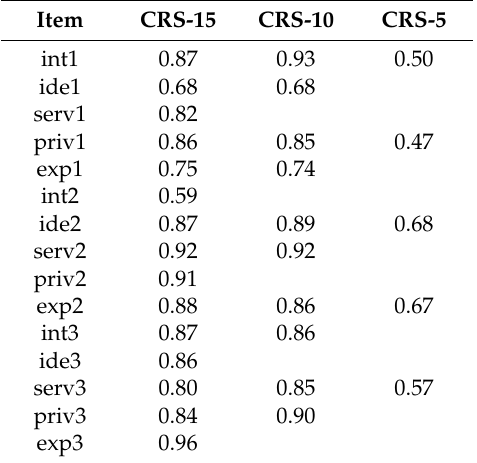
Table 6. R 2 of the items of the CRS in the confirmatory factor analysis.